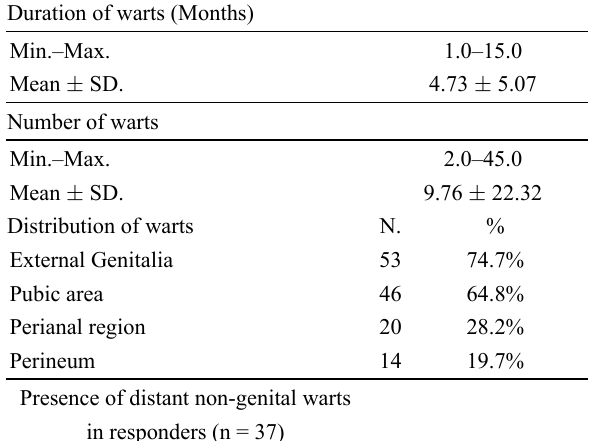
Fig. 2. A case of 36 years old male patient presented with gen- ital warts on right and left groin areas before and after PPD injection. A case of 36 years old male patient presented with gen- ital warts, located on the right and left groin areas. Before PPD in- jection, serum IL-17 level was 79.3 Pg/mL. After injection, serum IL-17 level was 110.3 Pg/mL. (A) Right groin warts before PPD injection, (B) complete removal of warts in right groin area after 6 sessions of PPD injection, 2 weeks interval, (C) Left groin warts before injection and (D) complete removal of warts in left groin area after PPD